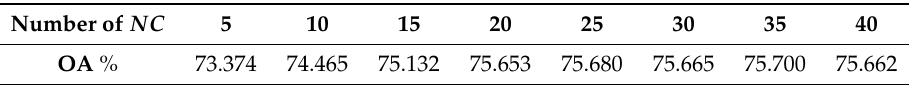
Table 1. The OA values obtained by the proposed algorithm with different NC values.